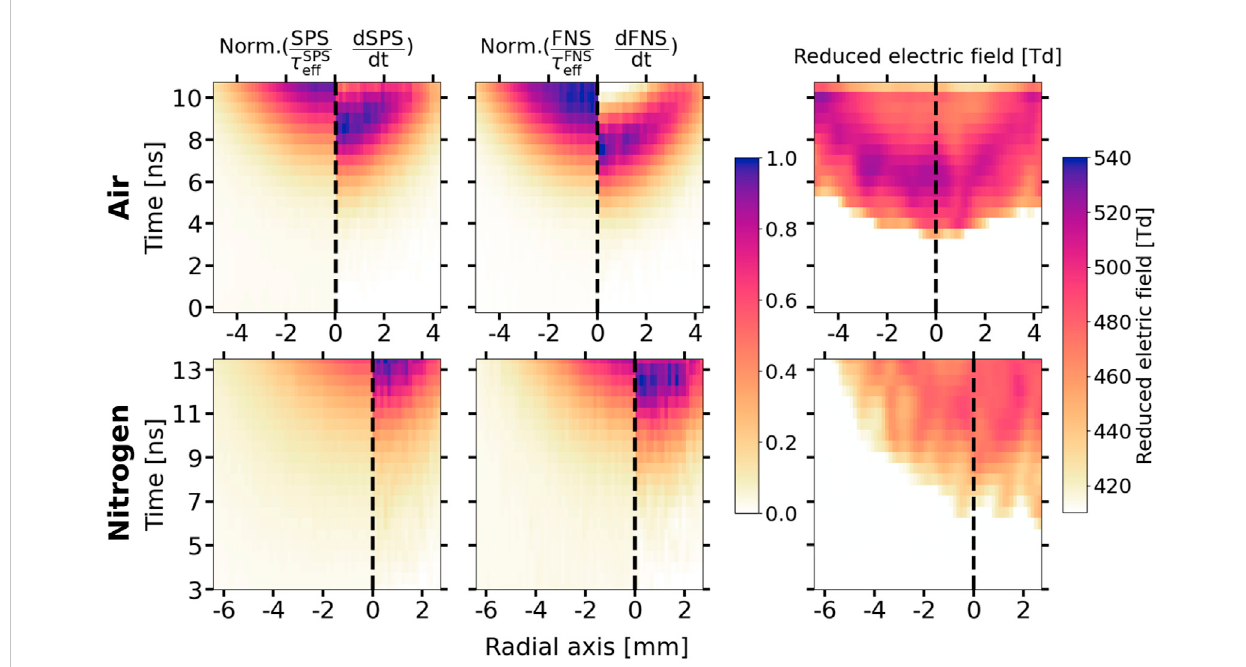
FIGURE 9 Heatmapsofdownwardfacingstreamers,showingthespatialandtemporalpro fi lesofthevariablesusedincalculatingthereducedelectric fi eldand oftheresultingreducedelectric fi eld.Abelinversionwasnotappliedtothedatadisplayedinthis fi gure.Onlyhalfofthedataisshownduetotheassumed symmetry, the dashed line indicates this symmetry axis, which is shifted off center for the pure Nitrogen results. For the reduced electric fi eld the full spatial data range is displayed, while the fi eld is cut off at 420Td. Intensities are divided by their respective effective lifetimes (left side) and their derivatives (right side) for SPS(2 – 5) and FNS(0 – 0). The upper row is for synthetic air and the lower row is for pure nitrogen. All of the presented data underwent Gaussian